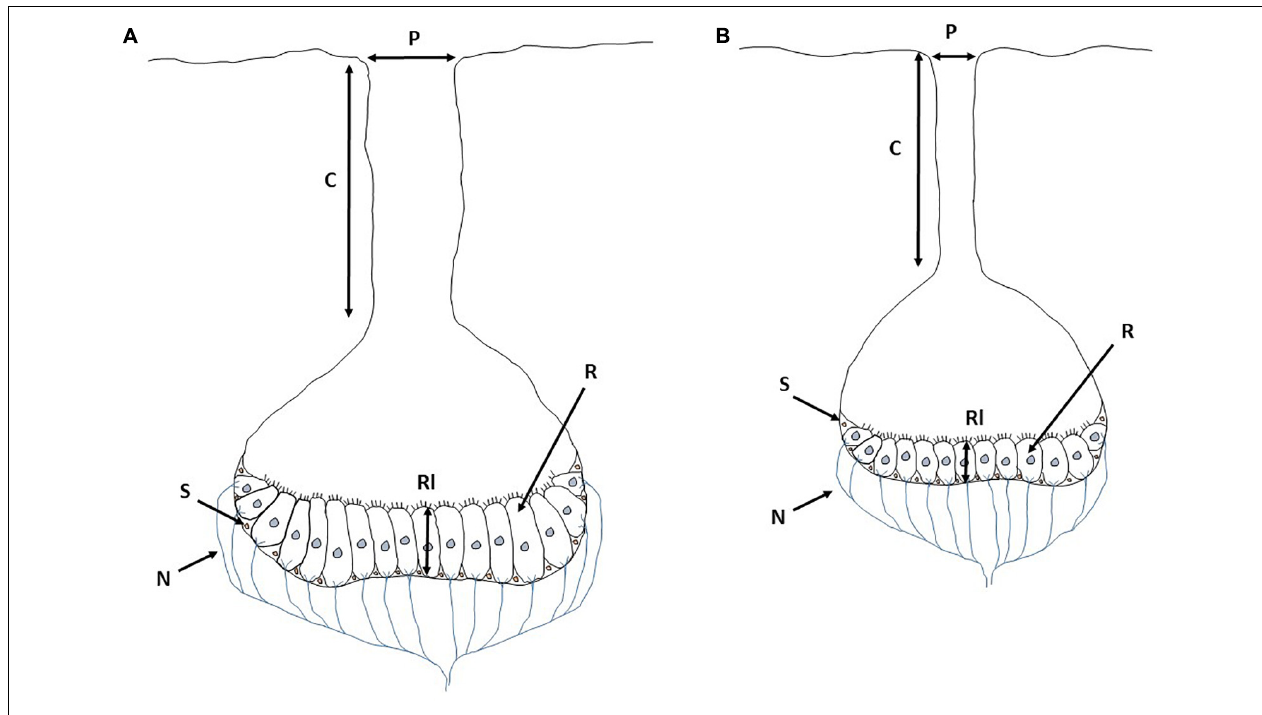
FIGURE 5 | Expected morphological divergence in ampullary organ under (A) high (white water type) and (B) low (Amazon black and clear water types) electric conductivity, according to Gauthier et al. (2015). C, Ampullary canal; P, Pore; R, Receptor cells (cell with gray nucleus in this scheme); Rl, Receptors length; S, Supporting cell (cell with light pink nucleus in this scheme); N, Nerve. Draws based on images found in Collin and Whitehead (2004) and Gauthier et al. (2015).